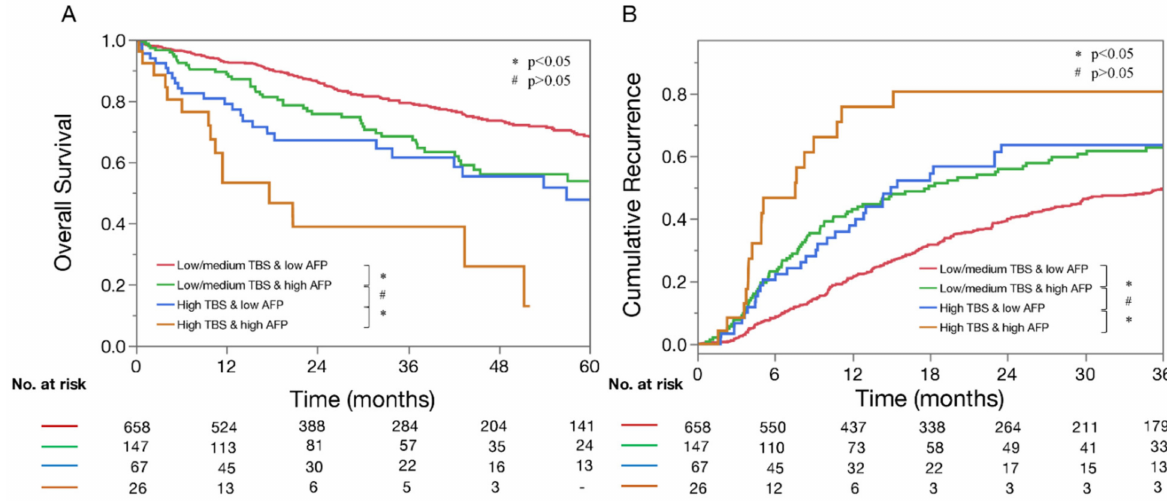
Figure 1. Kaplan–Meier curves demonstrating differences in OS ( A ) and recurrence ( B ) among patients with low–medium tumor burden score (TBS)/low a-fetoprotein (AFP), low–medium TBS/high AFP, high TBS/low AFP and high TBS/high AFP. * p < 0.05, # p >